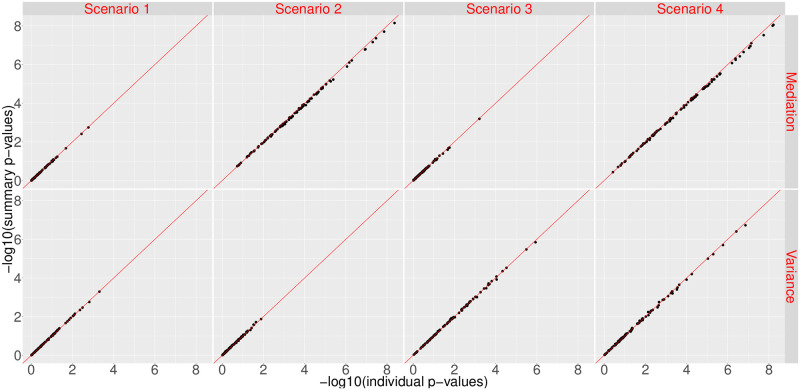
Scatter plots of −log10(p-values) for testing the mediation effect and variance component for sMiST compared with individual level data based MiST in the presence of confounding.